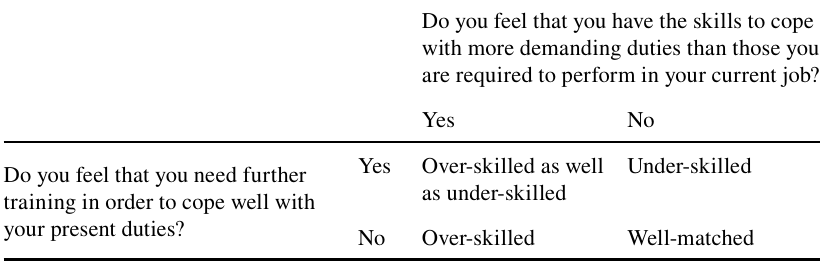
Self-reported skill mismatch in the PIAAC background questionnaire Do you feel that you have the skills to cope with more demanding duties than those you are required to perform in your current job? Yes No Yes Over-skilled as well Under-skilled Do you feel that you need further as under-skilled training in order to cope well with your present duties? No Over-skilled